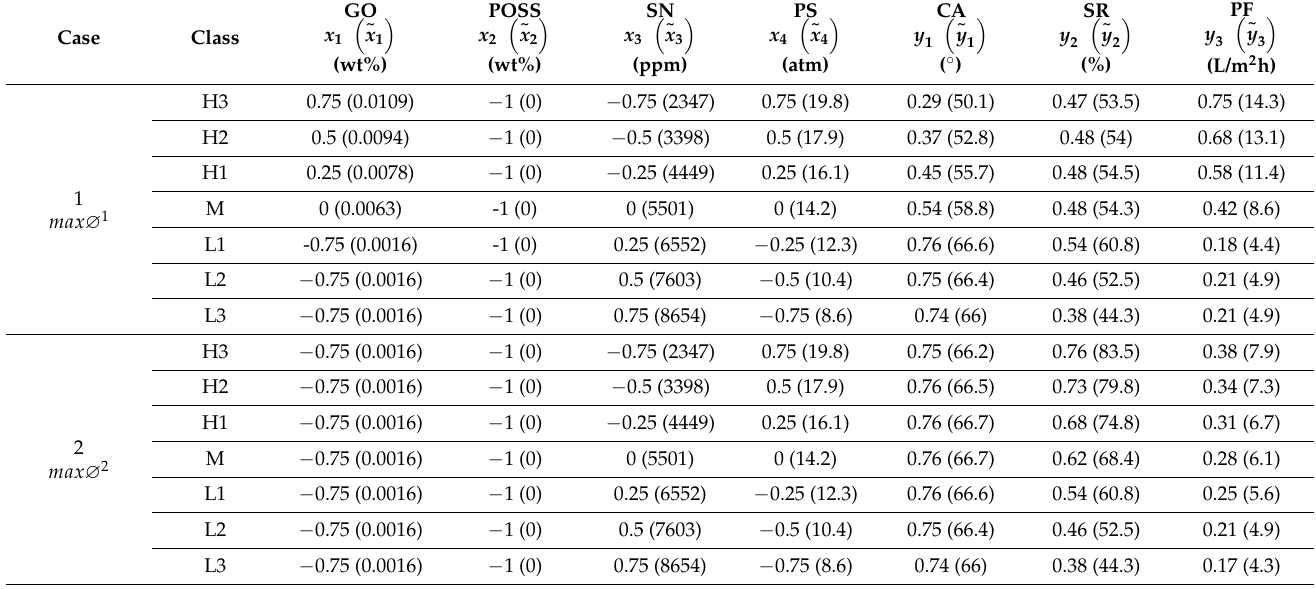
Table 8. Optimized solutions obtained from the interaction of the three cases defined in Table 6 and the seven classes described in Table